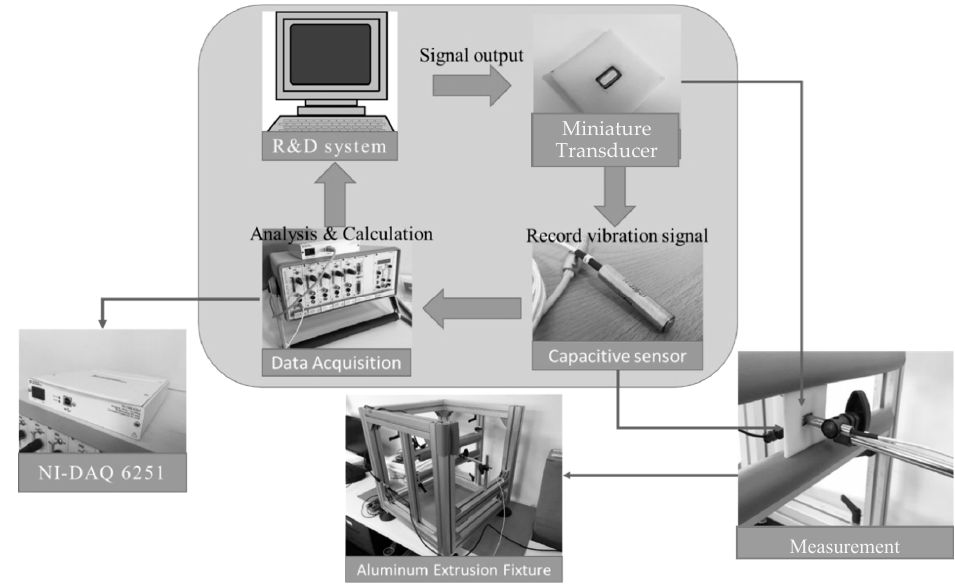
Figure 9. Capacitance displacement measurement system procedure.